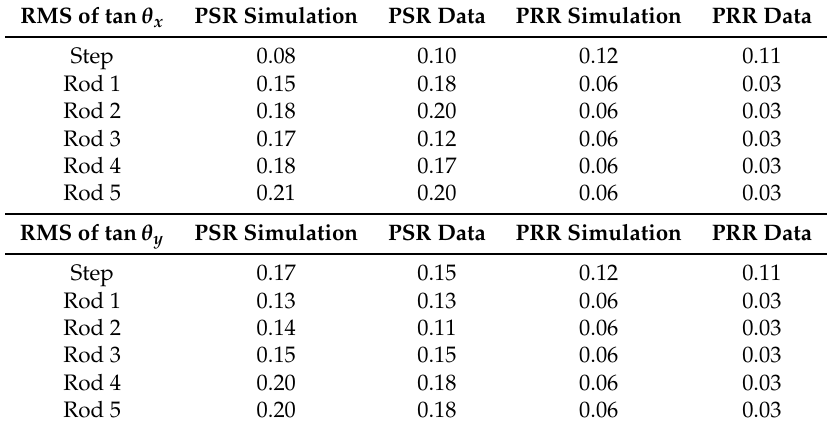
Table 1. Experimental data and Monte Carlo simulation of contrast for Phantom 1 and Phantom 2, calculated with proton scattering radiography (PSR) and proton range radiography (PRR). The PRR data and simulation are taken from